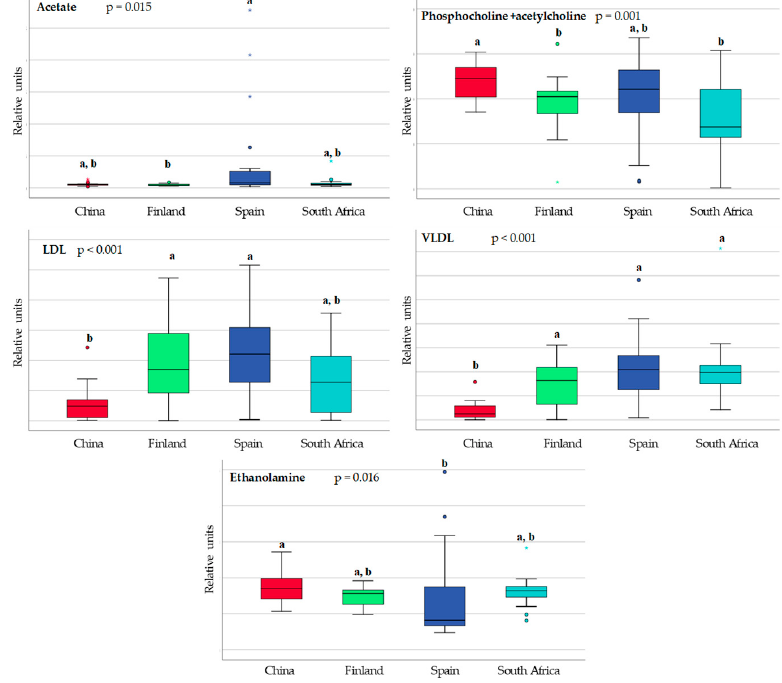
Figure 5. Box and whisker plot showing statistical significant differences in fatty acids and related metabolites in breast milk in samples from China (red), Finland (green), Spain (blue) and South Africa (pale blue). Data are expressed in relative units. Each bar represents the smallest observation, lower quartile ( Q1 ), median, upper quartile ( Q3 ) and largest observation. Circles and stars indicate outlier data. Differences among countries were calculated using the Kruskal–Wallis test. Unlike letters indicate statistically significant differences among countries. LDL and VLDL should be consider LDL- and VLDL-like particles with similar nuclear magnetic resonances (NMR), structure and mobility than plasma LDL and VLDL.